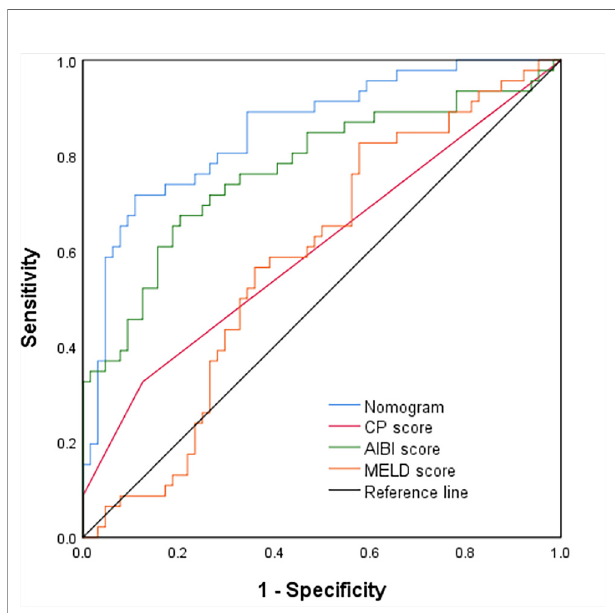
FIGURE 4 | Comparison of predictive accuracy for post-hepatectomy liver failure between the nomogram and the conventional models (CP score, MELD score, and ALBI score) by the validation cohort.